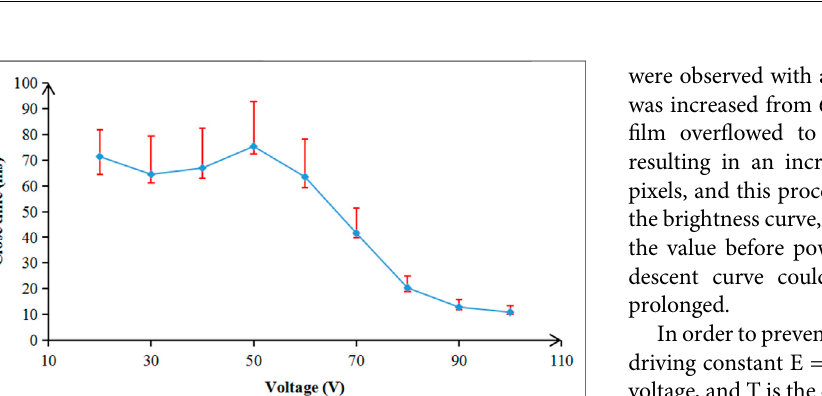
FIGURE 11| Comparison of oil fi lm closing timeamong different driving voltages with equivalent driving constraints. The larger the pixelaperture ratio, the faster of rewetting the whole pixel.